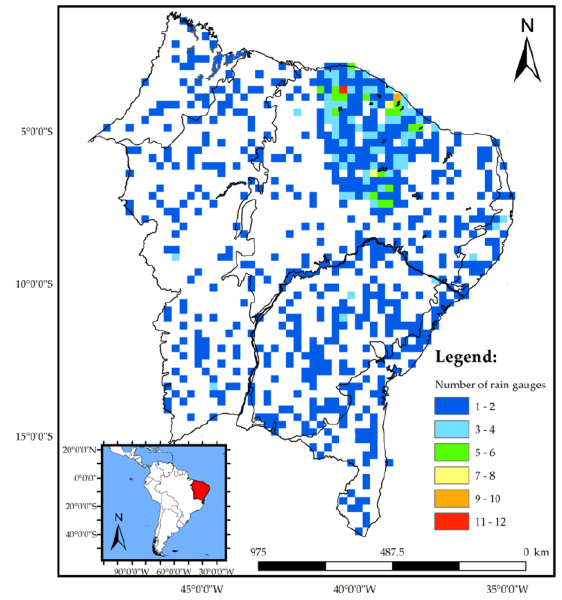
Figure 2. The spatial distribution of rain gauges used in the generation of the GBGR dataset provided by the Brazilian Water Agency (ANA), the National Institute of Meteorology (INMET), and the Water and Electric Energy Department of São Paulo state (DAEE) within the NEB [61]. The number of rain gauges depicts the median value for each grid during the period 1998 – 2015. The area of each grid is equal to 0.25° × 0.25°. Whited cells depict grids without rain gauges.